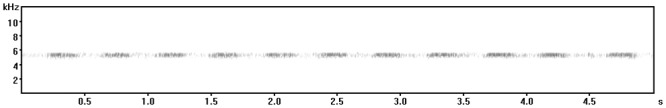
Spectrogram of calls series of Liuixalus shiwandashan sp. nov.The recording was high-pass filtered (above 5.5 kHz) to avoid high-frequence noise. Calls for figure spectrogram were created using 22005 Hz sampling frequency. Figure spectrogram was created using Hamming window, FFT-length 512 points, frame 100%, and overlap 75%.